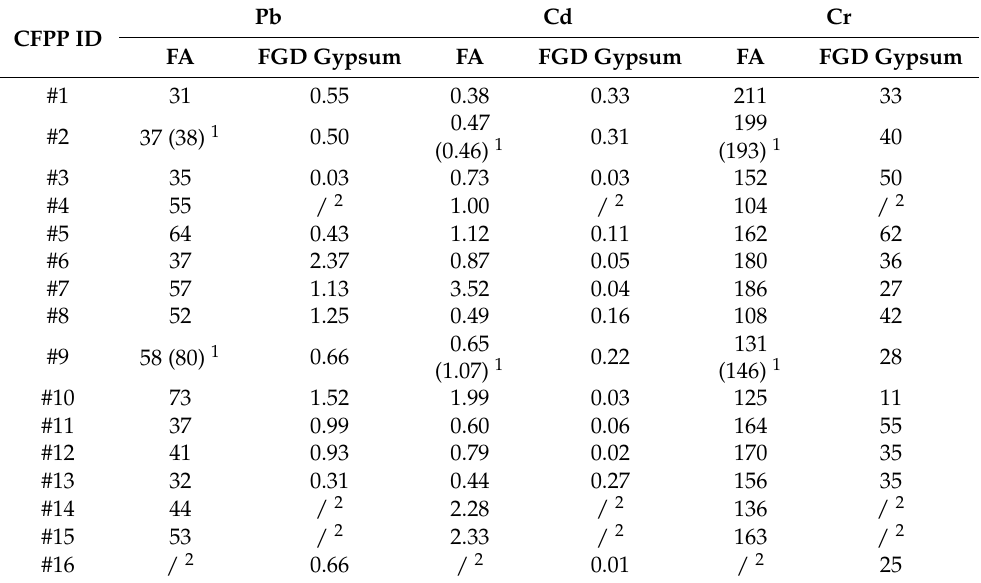
Table 3. The concentrations of heavy metals in FA and FGD gypsum samples (unit: mg/kg). Pb Cd Cr CFPP ID FA FGD Gypsum FA